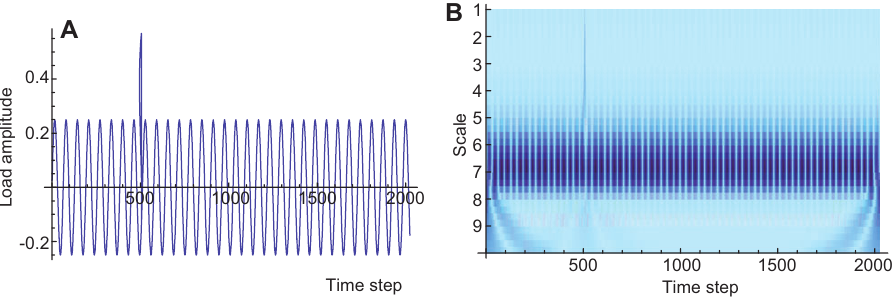
Figure 5 (A) A delta-type function superimposed on a cycling one shown in a time vs. mechanical load amplitude plot. (B) The wavelet scalogram of the function in (A) showing, in dark blue, the existence of wavelet coefficients of significant energy in time vs. scale. Scale 1 is the smallest one equal to one time step, and scale 10 is the largest scale of the order of the entire time